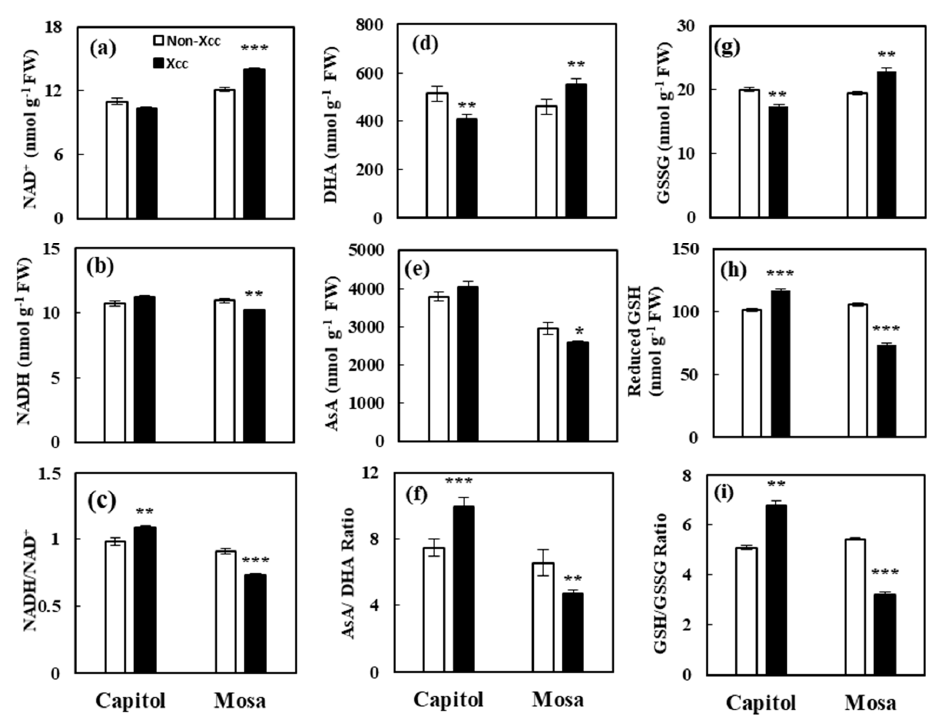
Figure 7. NADH, ascorbate, and glutathione redox statuses in responses to Xanthomonas campestris pv. campestris (Xcc) inoculation in B. napus cultivars: ( a ) NAD + , ( b ) NADH, ( c ) NADH/NAD + ratio, ( d ) dehydroascorbate (DHA), ( e ) reduced ascorbate (AsA), and ( f ) the ratio of AsA to DHA, ( g ) oxidized glutathione (GSSG), ( h ) reduced glutathione (GSH) content, and ( i ) the ratio of GSH to GSSG. Data are presented as means ± SE for n = 3. Asterisks indicate significant differences between the Xcc noninoculated (control) and Xcc-inoculated plants; * p < 0.05, ** p < 0.01, and *** p < 0.001.